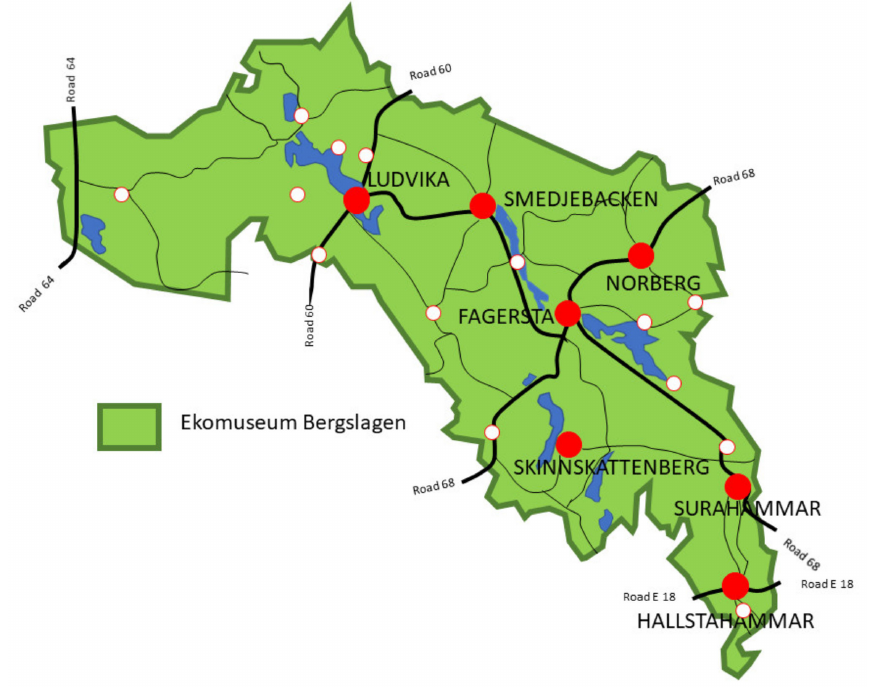
Figure 13. Ecomuseum Bergslagern